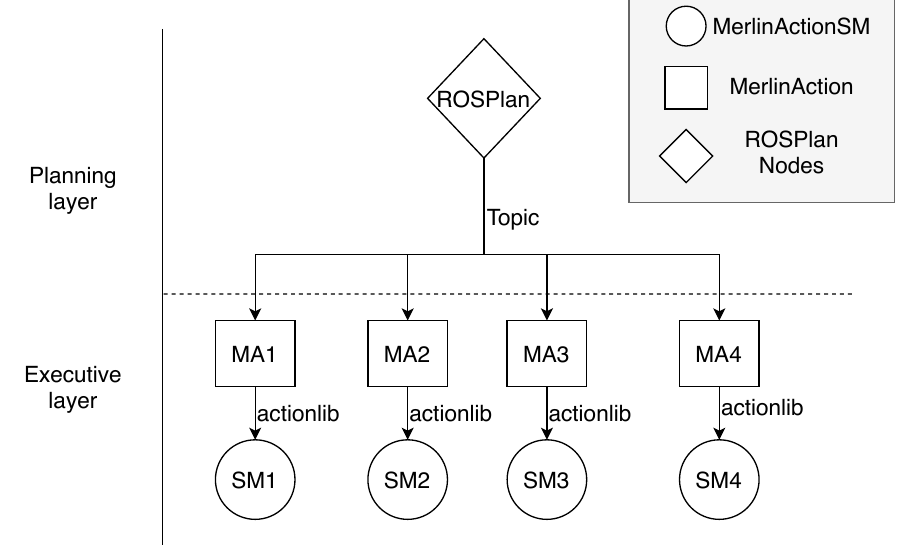
Figure 5. Communication diagram of Executive layer (Deliberative) and ROSPlan